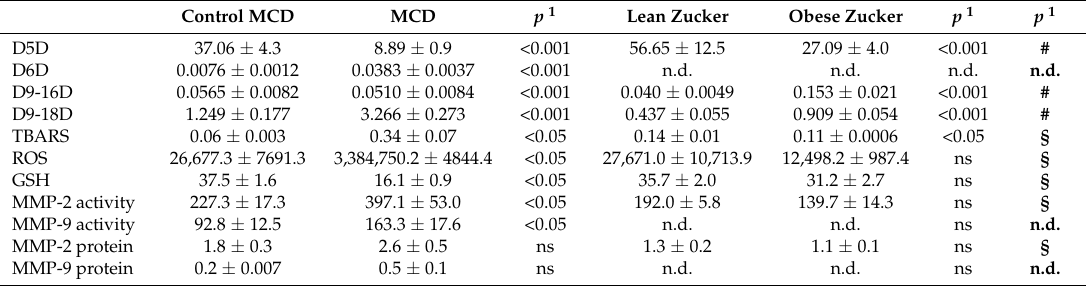
Hepatic desaturases, oxidative stress and matrix metalloproteinases (MMPs) in methionine-choline-deficient (MCD) and Obese Zucker rats. Control MCD MCD